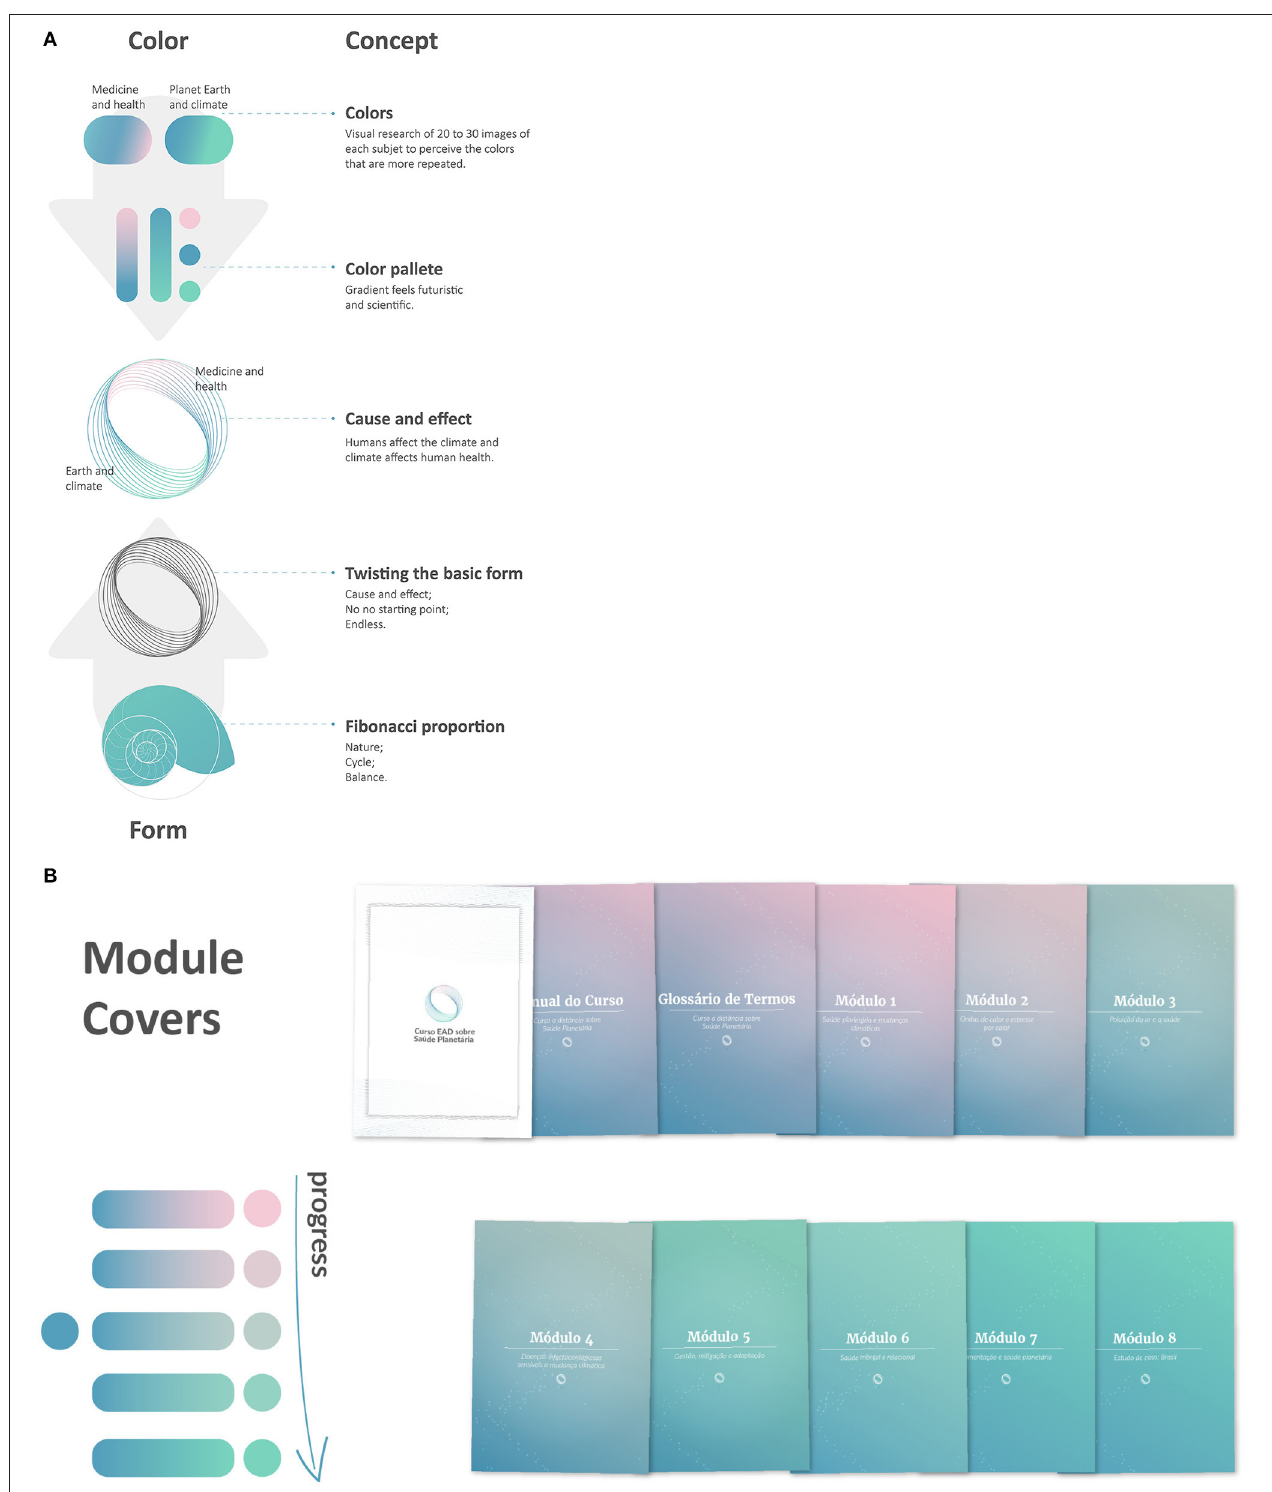
FIGURE 2 | Art design structure and illustration of the Planetary Health MOOC with the Fibonacci sequence (A) and the palette colors choice (B) . Illustration credit: Iasmine Paim Nique da Silva and Lorenzo Costa Kupstaitis.